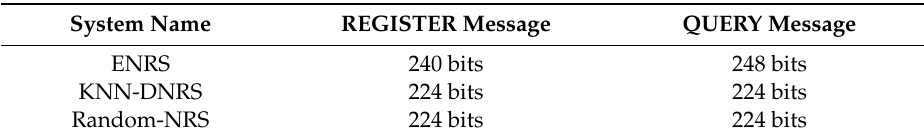
Table 4. The length of